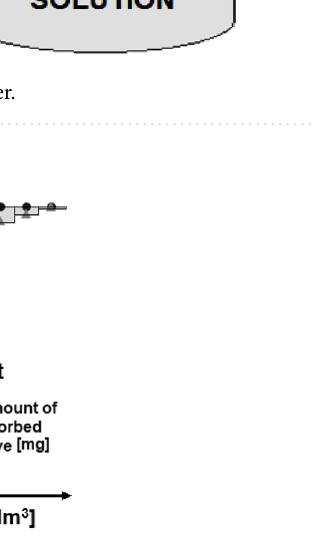
Figure 3. Computation scheme of the amount of dye sorbed on the sorbent over sorption time (experimental